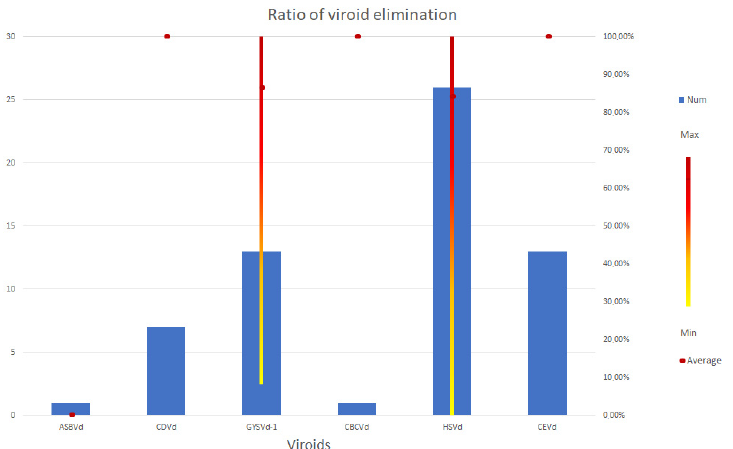
Figure 4. Elimination efficiencies of different viroids sorted by ICTV taxonomy. Blue bars show the number of available data for the different viroids.